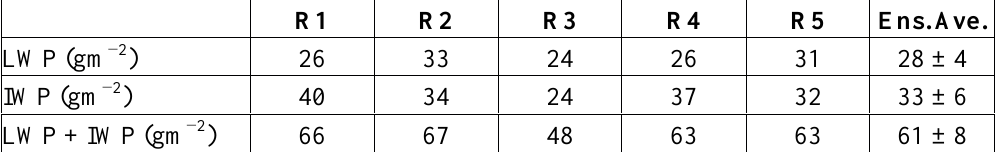
Table 2. The mean cloud water paths (gm −2 ) for liquid (LWP), ice (IWP) and total (LWP + IWP) for the different ensembles members as well as the ensemble mean and standard deviations. R1 R2 R3 R4 R5 Ens.